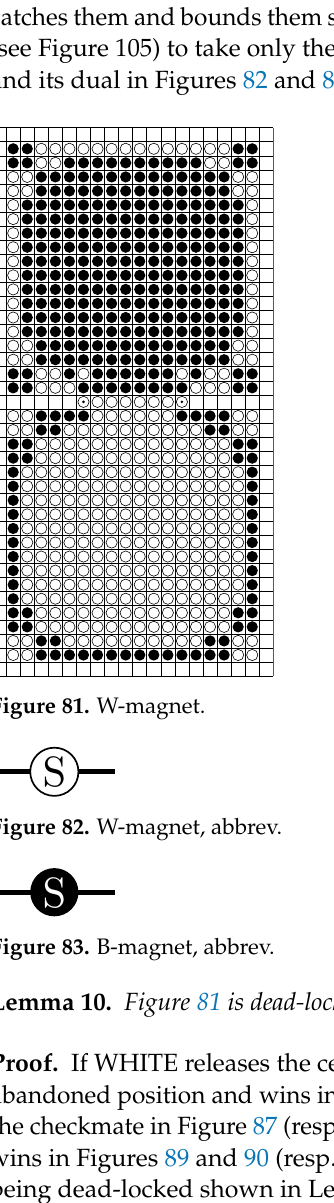
Figure 83. B-magnet, abbrev.